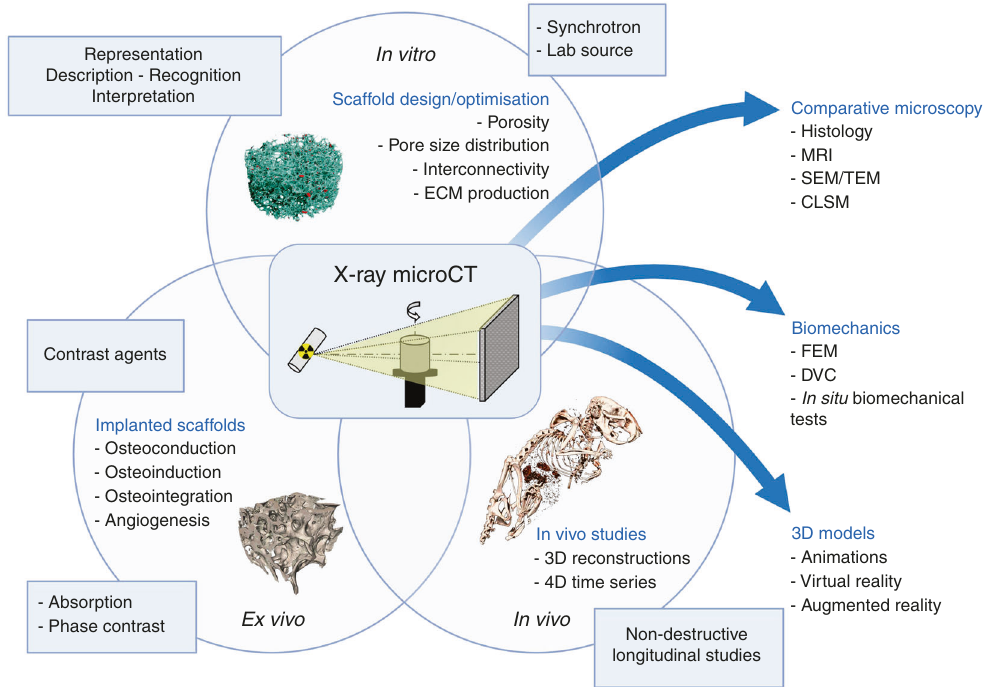
Fig. 6 Schematic representation of the potential of microCT analysis for musculoskeletal tissue engineering. This nondestructive technique can be used for different applications for biomaterials per se or in combination with cells and tissue (both ex vivo and in vivo). The produced image dataset can be compared with that from different microscopy techniques, combined with biomechanical tests or used for 3D